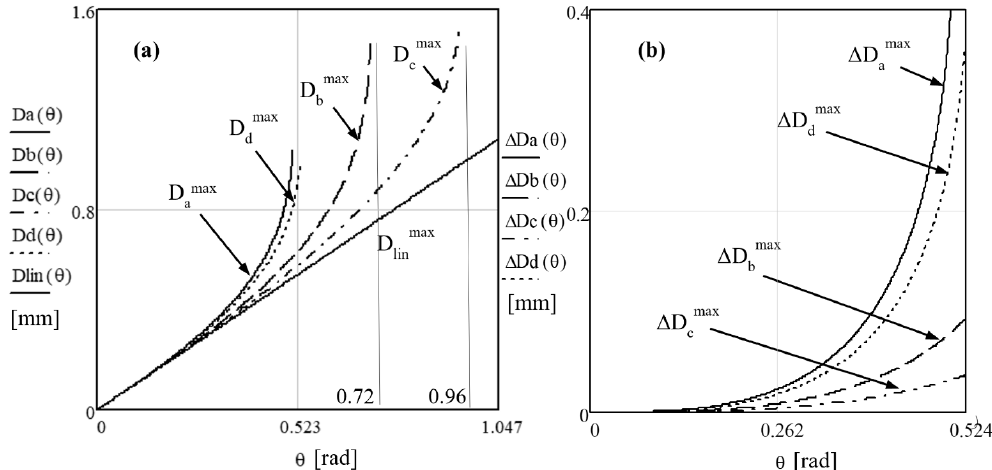
Figure 9. ( a ) Maximum angular deviations D max , j = a, b, c, d as functions of the angle θ of identical prisms, presented in comparison to the approximate/linearized one, D max , Equation (7); ( b ) the absolute error between the maximum angular deviations and their linear approximation. A refractive index n = 1.517 was considered for both prisms.